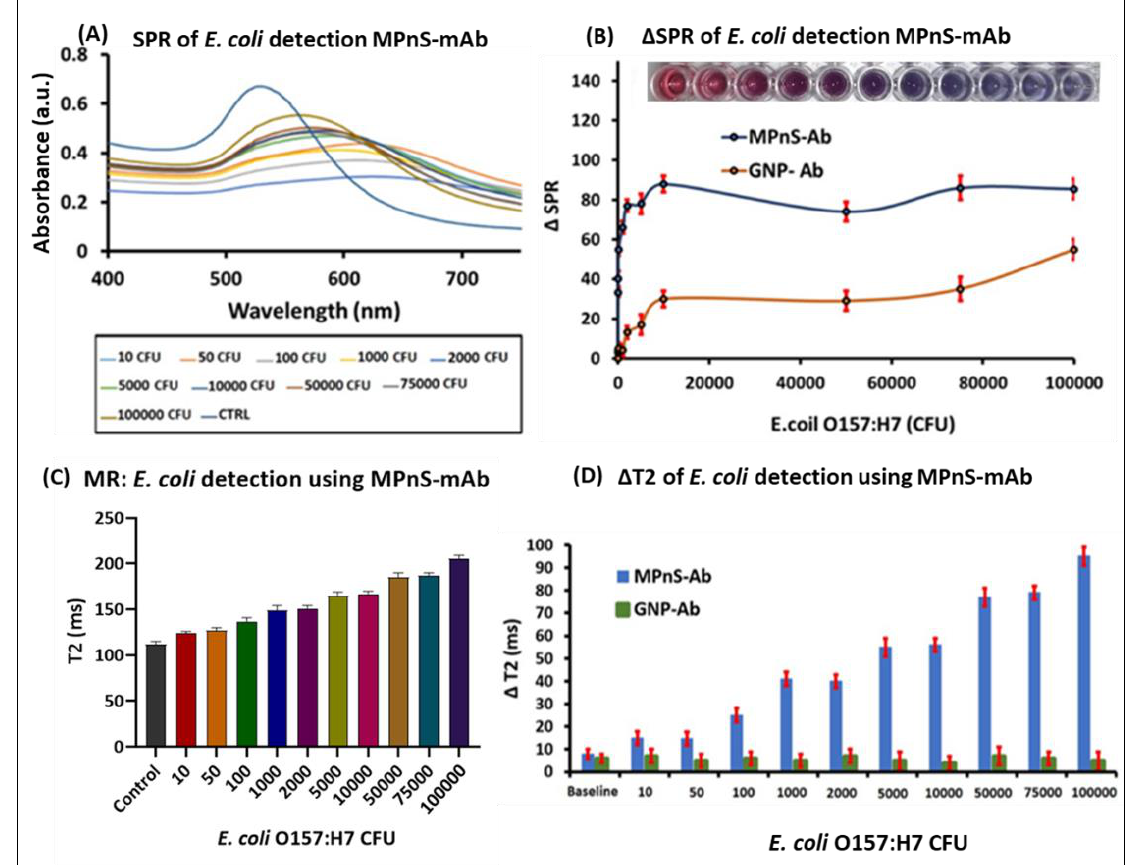
Figure 2. Multimodal detection of E. coli O157:H7: ( A ) Increasing CFUs of E. coli O157:H7 (10 1 to 10 5 ) were added to the functional MPnS-mAb and the corresponding UV-Vis spectra showing detection. ( B ) Change in absorption maxima ( ∆ SPR) of MPnS-mAb conjugate and that compared with GNPs-mAb, inset: color changes in response to different CFUs of E. coli O157:H7 mixed with MPnS-mAb. ( C ) Corresponding T2 MR values of detection. ( D ) ∆ T2 values compared with detection using GNPs-mAb.